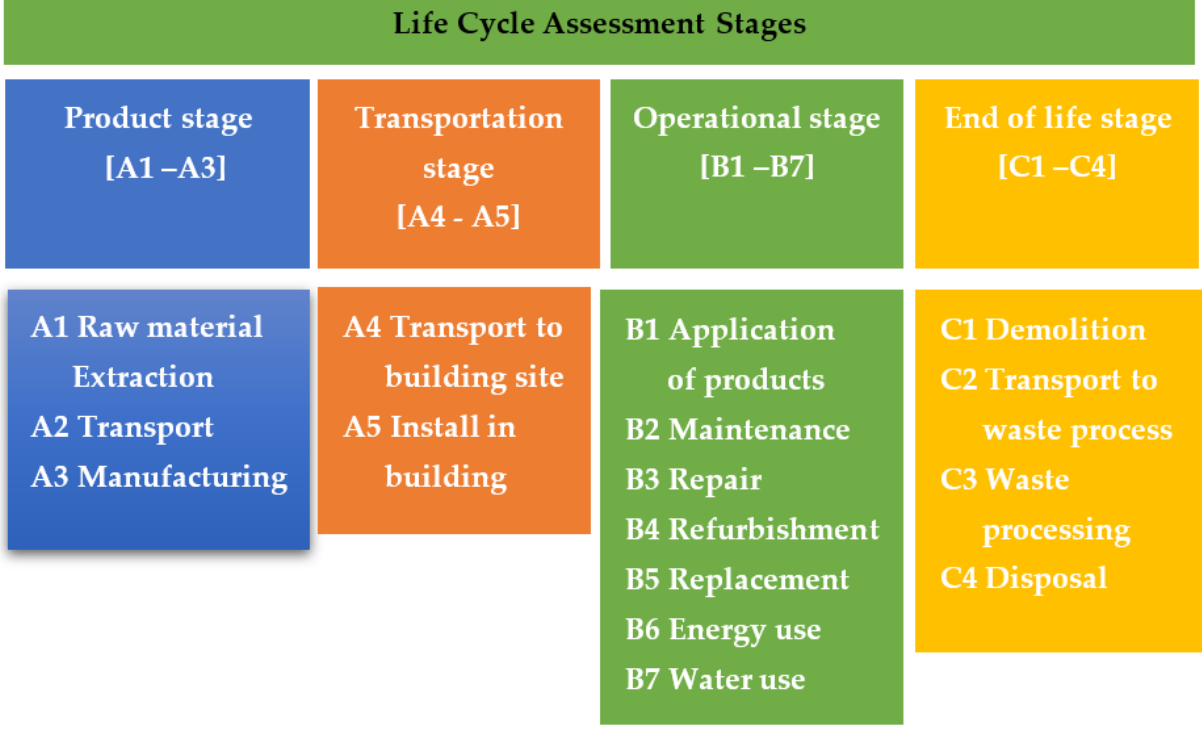
Figure 1. Life cycle assessment stages.